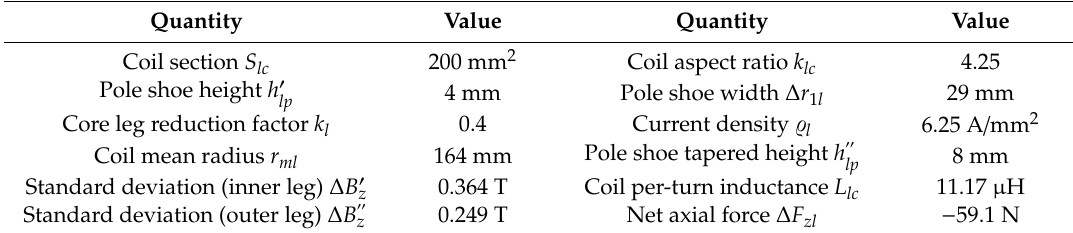
Table 4. Design quantities of the AHMB lower side.